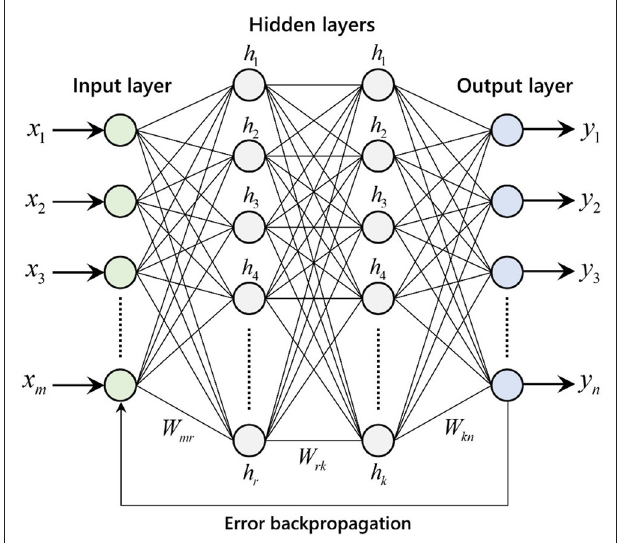
FIGURE 4 | Architecture of multilayer artificial neural network with error backpropagation.